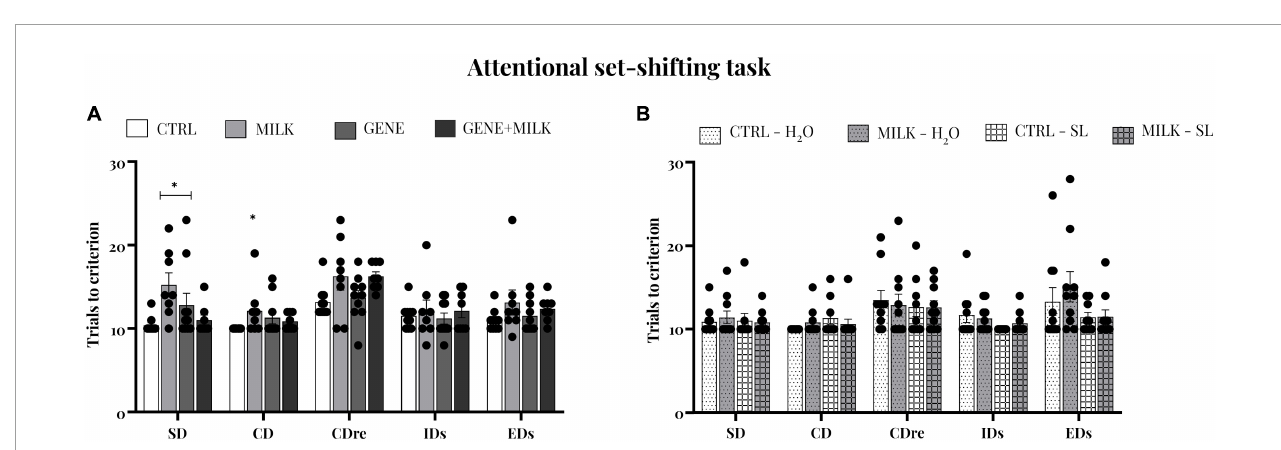
FIGURE5 Attentional set-shifting task, trials to reach criterion: number of trials completed to attain the criterion of all phases in experiment 1 (A) and experiment 2 (B) . Regarding the first study, the MILK group committed required a higher number of trials to criterion compared to CTRL group; ∗ p < 0.05 in post-hoc tests compared to CTRL